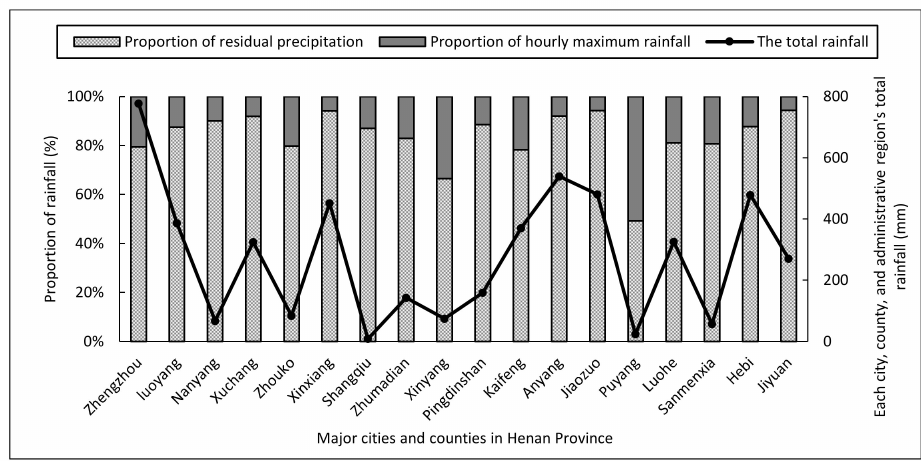
Figure 9. Proportion of hourly maximum rainfall of the 20 July rainstorm event in